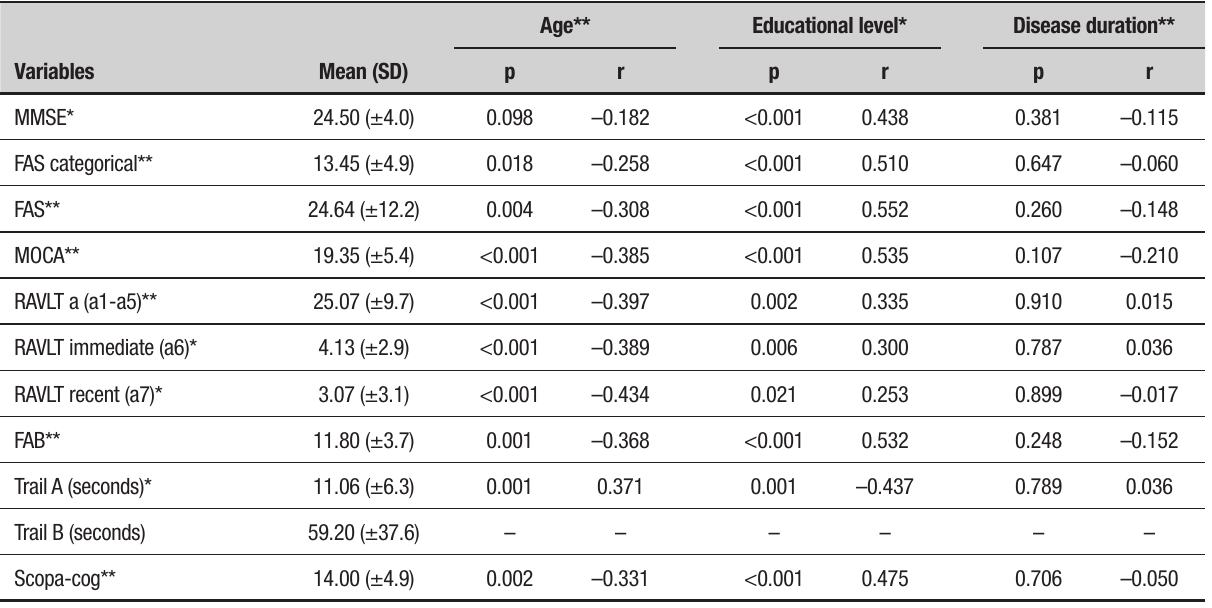
Table 2. Correlation of age, education and disease duration with cognitive tests.